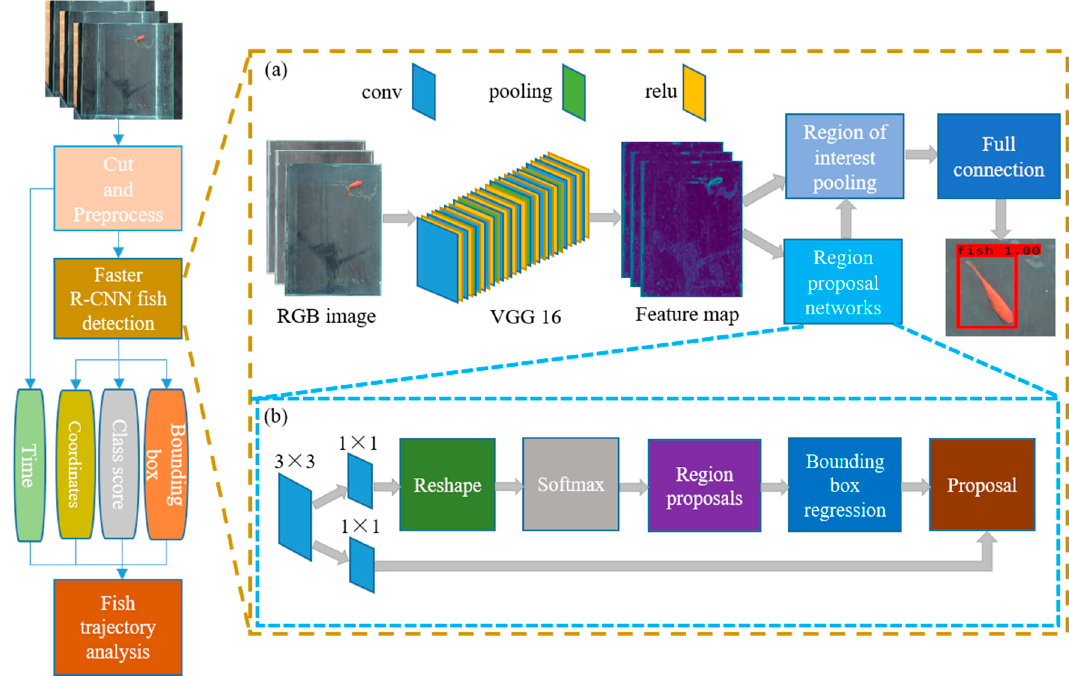
Figure 2. Recognition process of Faster region convolutional neural networks (R-CNN). ( a ) Structure of Faster R-CNN detector. ( b ) Detailed process of regional proposal networks (RPN).